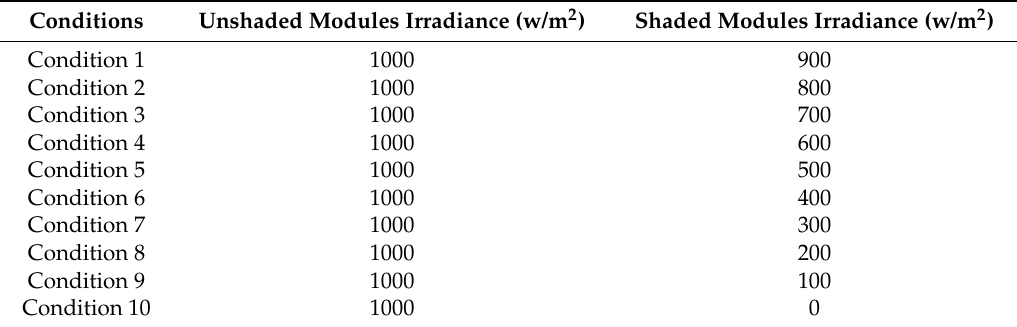
Table 1. Conditions applied to the experimental setups.